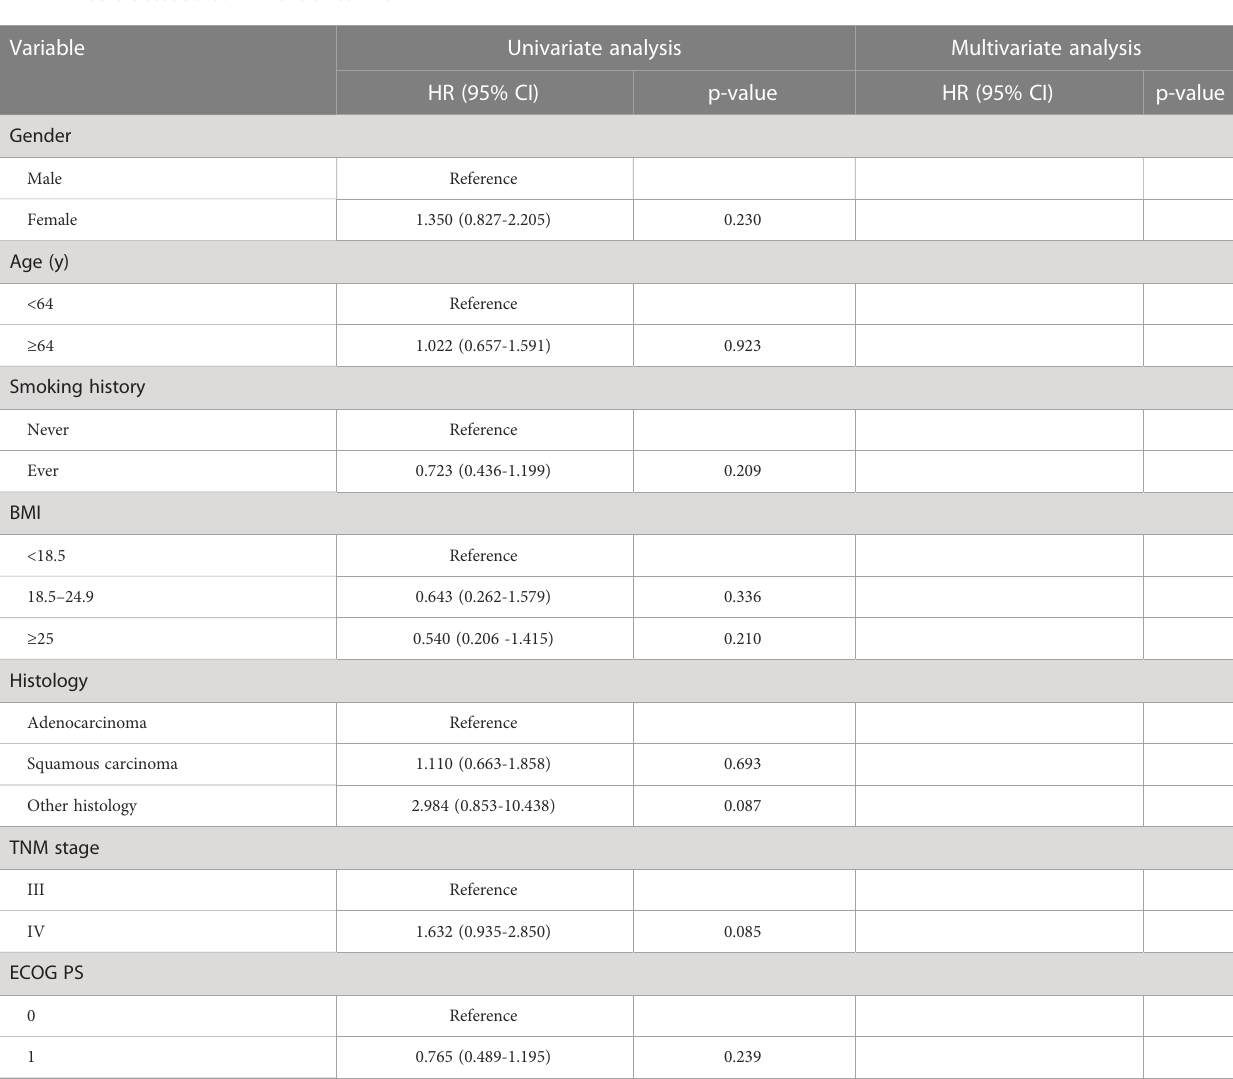
TABLE 4 Factors associated with overall